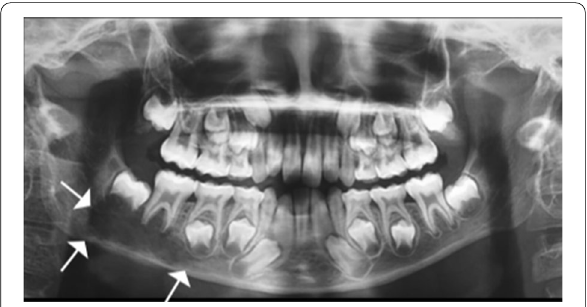
Fig. 3 OPG showing radiolucency in the region from E to 7 extending to lower border of mandible with ill-defined and irregular